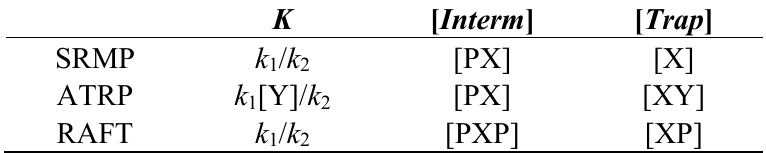
Table 1. Explicit representation of K , [ Interm ], and [ Trap ]. Note that XP and PX in reversible-addition-fragmentation chain-transfer polymerization (RAFT) shown in Figure 1 are the same species, whose concentration is represented by [XP] in this